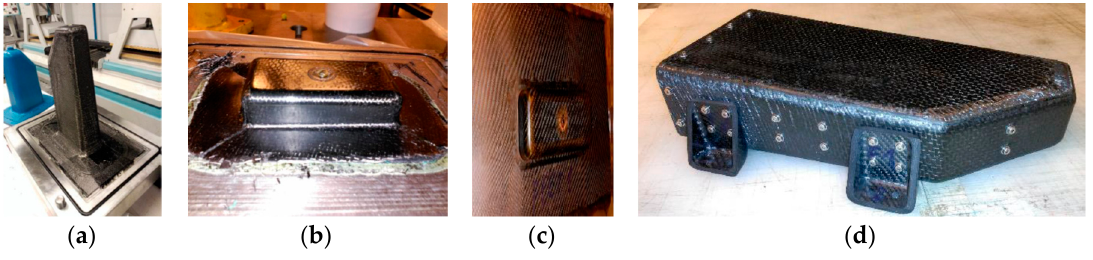
Figure 21. Photographs of final CFRP parts ( a ) box ( b ) lid ( c ) feet ( d ) breadboard.